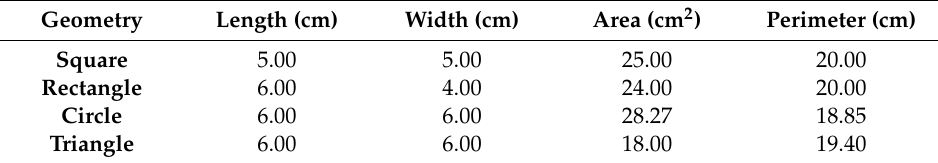
Table 2. The specific shape and size of the regular leaf graphics.